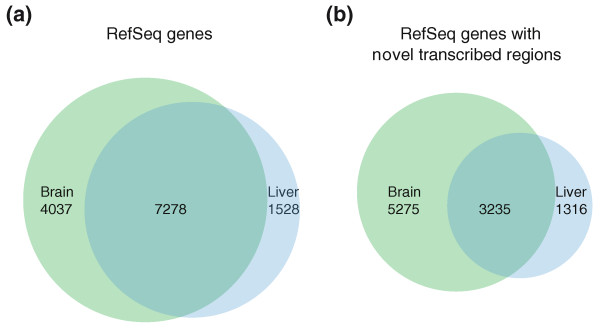
Tissue distribution of expressed genes and genes containing novel transcribed regions. The Venn-diagram illustrates the proportion of genes expressed only in brain, only in liver or in both tissues simultaneously. (a) The tissue distribution of expressed genes; (b) the tissue distribution of genes harboring at least one novel TR (found intronically or within 10 kb upstream or downstram of the gene).